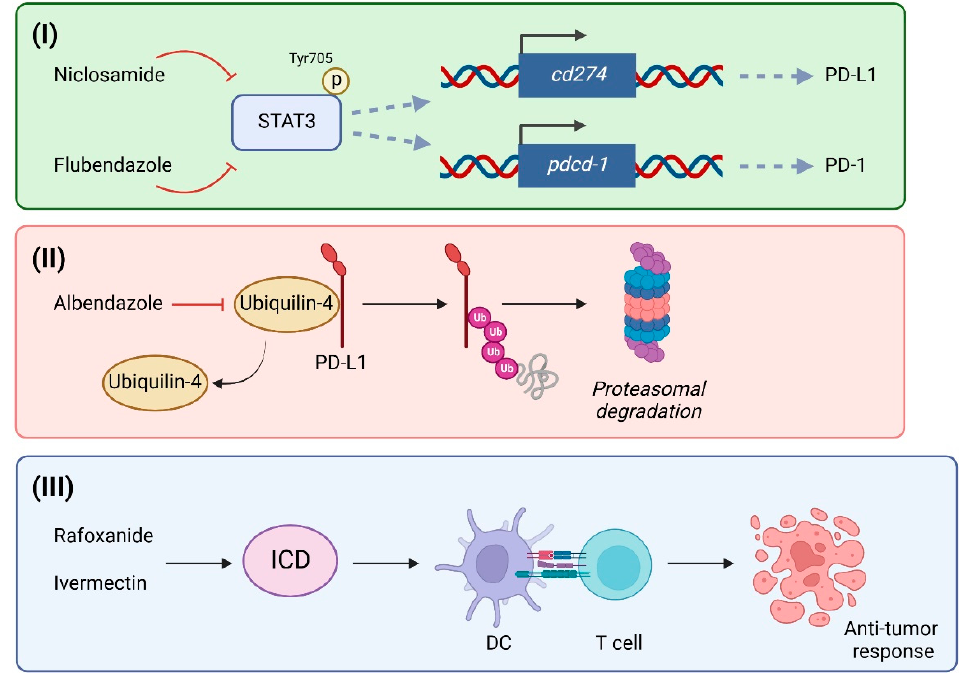
Figure 1. Some putative molecular mechanisms that underlie the ability of certain anthelmintic drugs to improve cancer immunotherapy. ( I ) Niclosamide and flubendazole suppress STAT3 phosphorylation/activation, thus, impairing the expression of PD-L1 and PD-1. ( II ) Albendazole negatively affects ubiquilin-4 expression/interaction with PD-L1, thus, promoting its degradation by the proteasome. ( III ) Rafoxanide and ivermectin promote bona fide immunogenic cell death in cancer cells and prime antitumor immune responses. Abbreviations: STAT- signal transducer and activator of transcription; PD-1: programmed cell death protein-1; PD-L1: programmed death-ligand 1; Ub: ubiquitin; ICD: immunogenic cell death; DC: dendritic cells. Created with Biorender.com.